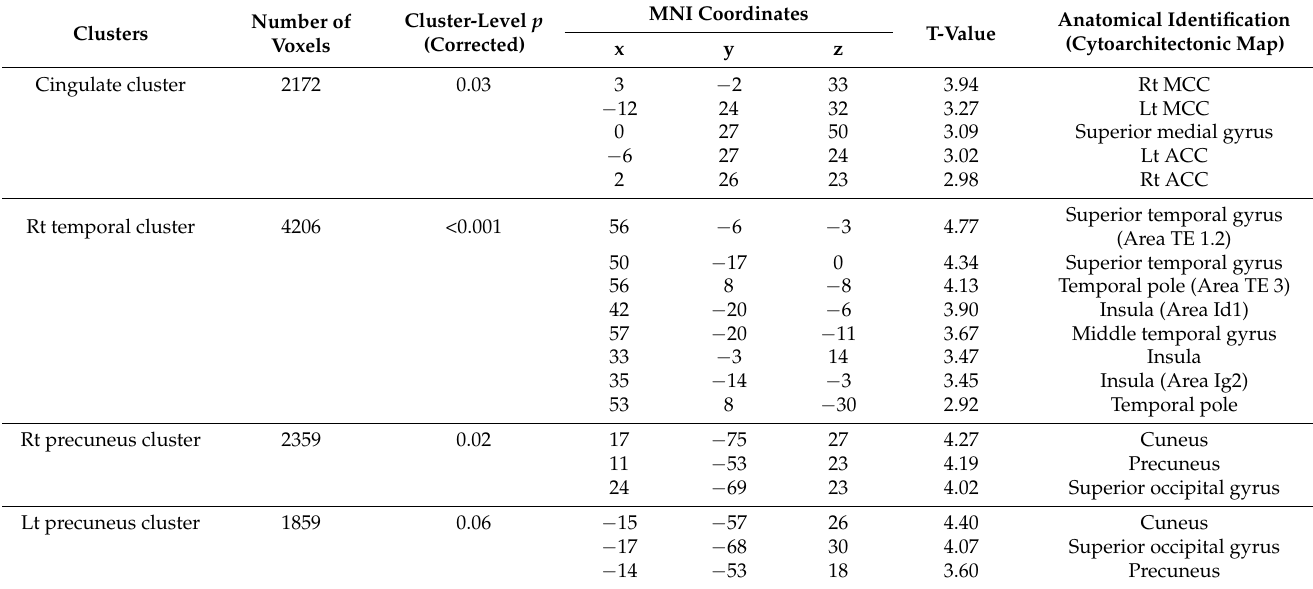
MNI Coordinates